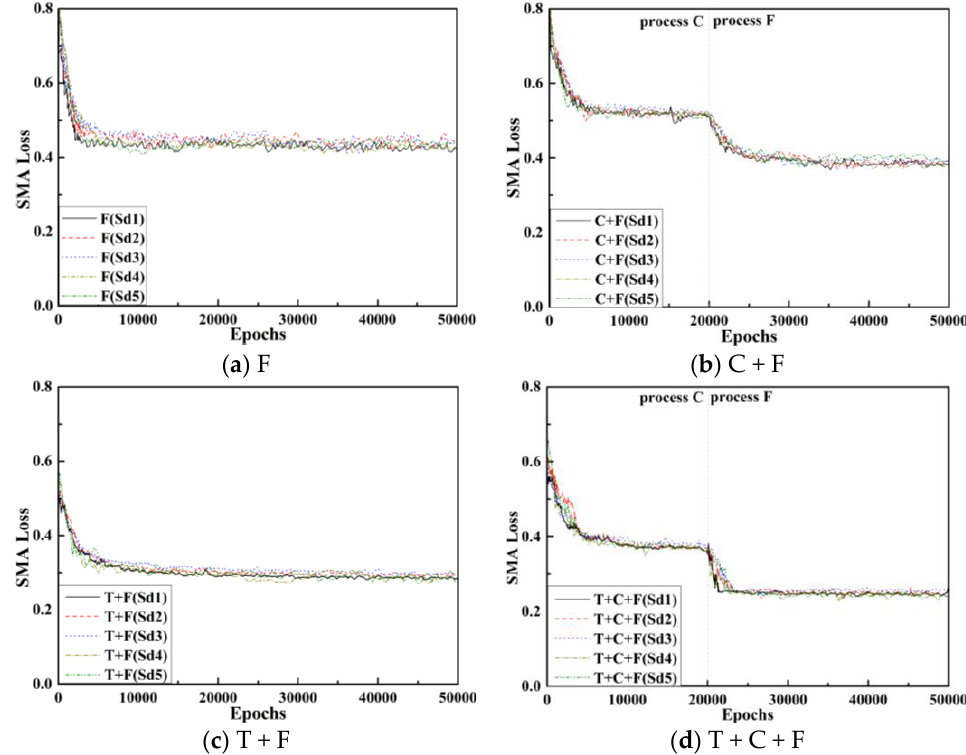
Figure 6. SMA loss curve.